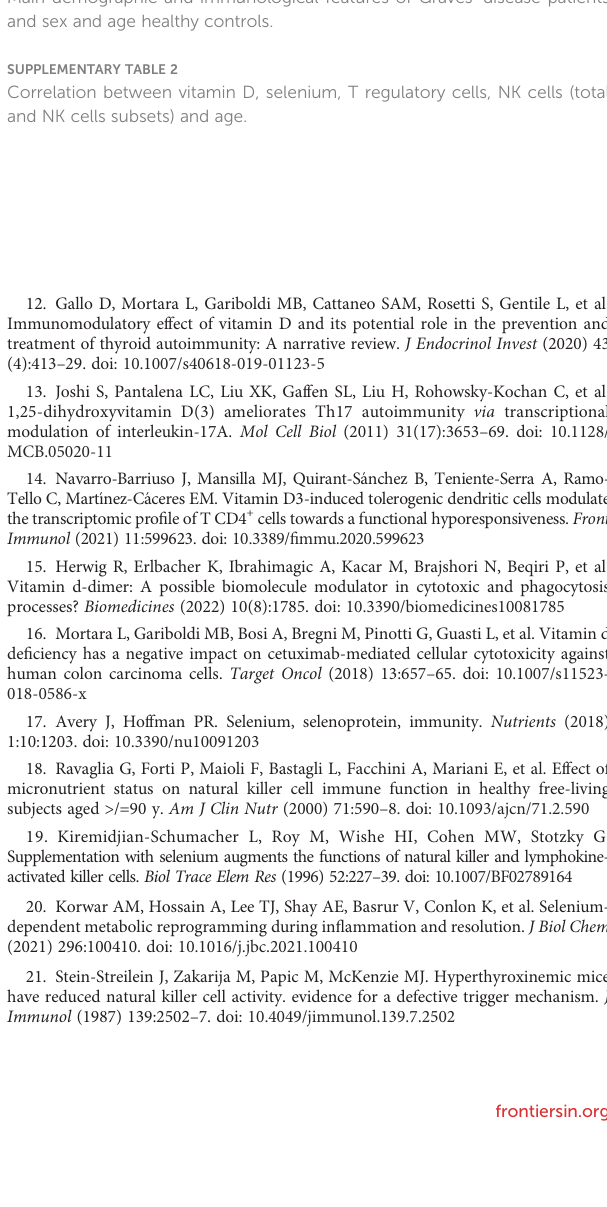
SUPPLEMENTARY TABLE 1 Main demographic and immunological features of Graves ’ disease patients and sex and age healthy controls. SUPPLEMENTARY TABLE 2 Correlation between vitamin D, selenium, T regulatory cells, NK cells (total and NK cells subsets) and